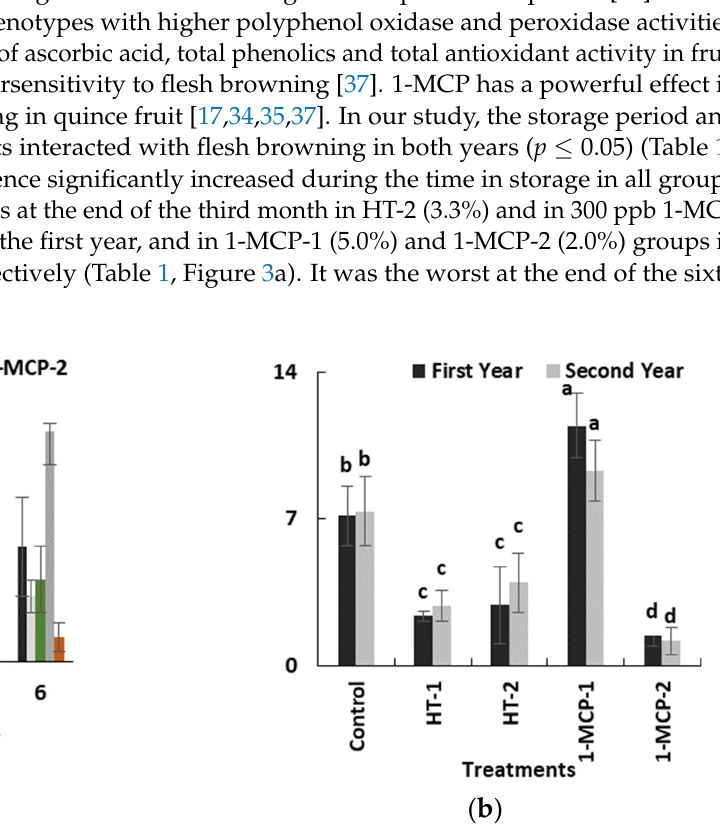
8 of 18 Figure 2. The effect of different postharvest treatments on peel ( a ) and flesh ( b ) color of quince fruit during long ‐ term cold storage period of 6 months at 0 ± 1 °C, 85–90% relative humidity and regular air conditions. Control—without postharvest treatment; HT ‐ 1—Hot water treatment at 50 ± 1 °C for 3 min; HT ‐ 2—Hot water treatment at 50 ± 1 °C for 5 min; 1 ‐ MCP ‐ 1—300 ppb 1 ‐ methylcyclopropane (1 ‐ MCP) treatment at 12 °C for 20 h; 1 ‐ MCP ‐ 2—1000 ppb 1 ‐ MCP treatment at 12 °C for 20 h. Vertical lines are the standard error of means. Different letters are significantly different, according to Tukey test, at p ≤ 0.05 significance level; ns—not significant at p ≤ 0.05. The higher hue values reflect color that is more greenish. Evidently, 1000 ppb 1 ‐ MCP treatment has effectively delayed chlorophyll degradation. The efficacy of HT ‐ 1 (95.57°), HT ‐ 2 (95.43°) and 1 ‐ MCP ‐ 1 (95.44°) treatments was lower than 1 ‐ MCP ‐ 2 in the first year.